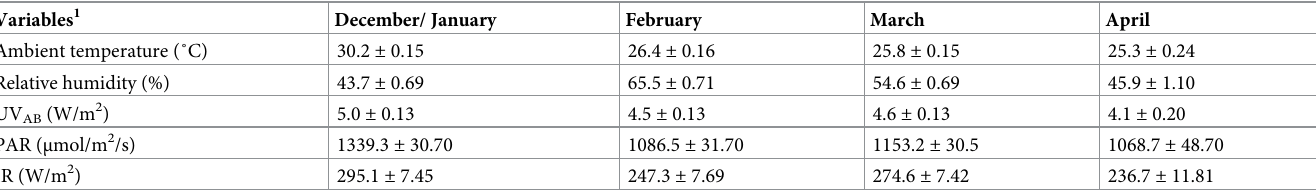
Table 4. Mean daily ( ± SEM) outdoor conditions during ranging time across the months in QLD (n = 94 days). Variables